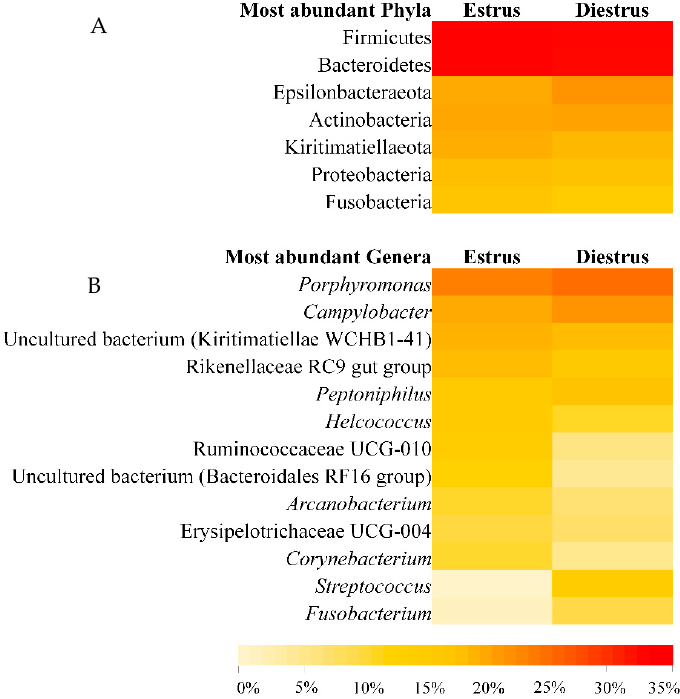
Figure 2. Mean bacterial phylum ( A ) and genus ( B ) taxonomic relative abundance classified by the ovarian phase. Only taxa with a mean relative abundance > 1.5% at estrus or diestrus are represented.